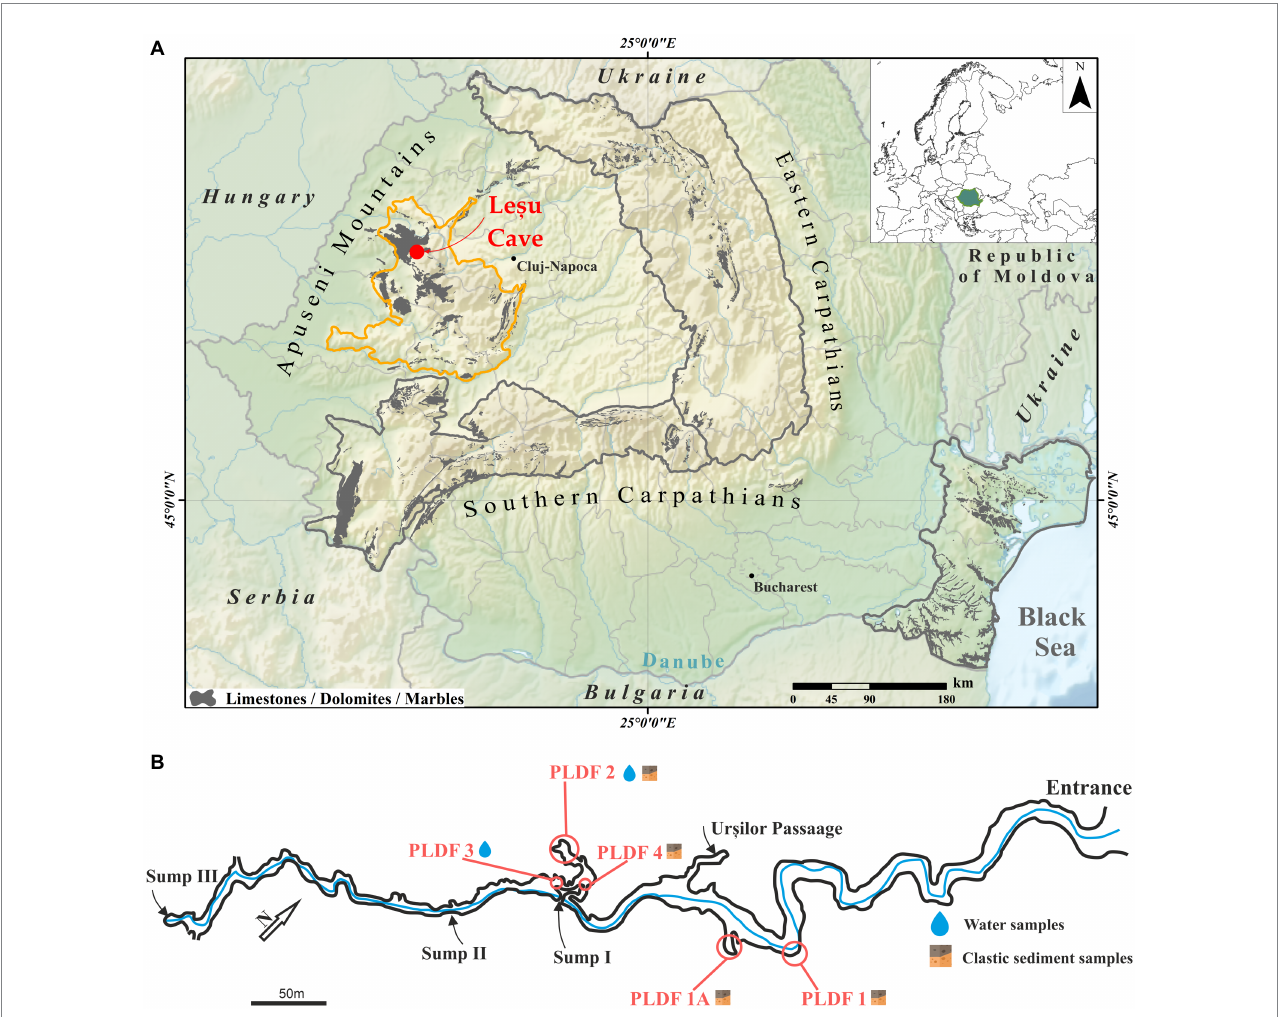
FIGURE 1 Geographical position of the Leșu Cave map ( A ; modified after Rusu, 1988) in Apuseni Mountains (NW part of Romania, maps modified in ArcGIS 10.1 from Wikipedia (https://ec.europa.eu/eurostat/web/gisco/geodata/reference-data/administrative-units-statistical-units/countries, last accessed 25th January 2023) and Eurostat (https://en.wikipedia.org/wiki/File:Relief_Map_of_Romania.png, last accessed 25th January 2023) © EuroGeographics for the administrative boundaries) with sampling sites and sample types collected (B) .